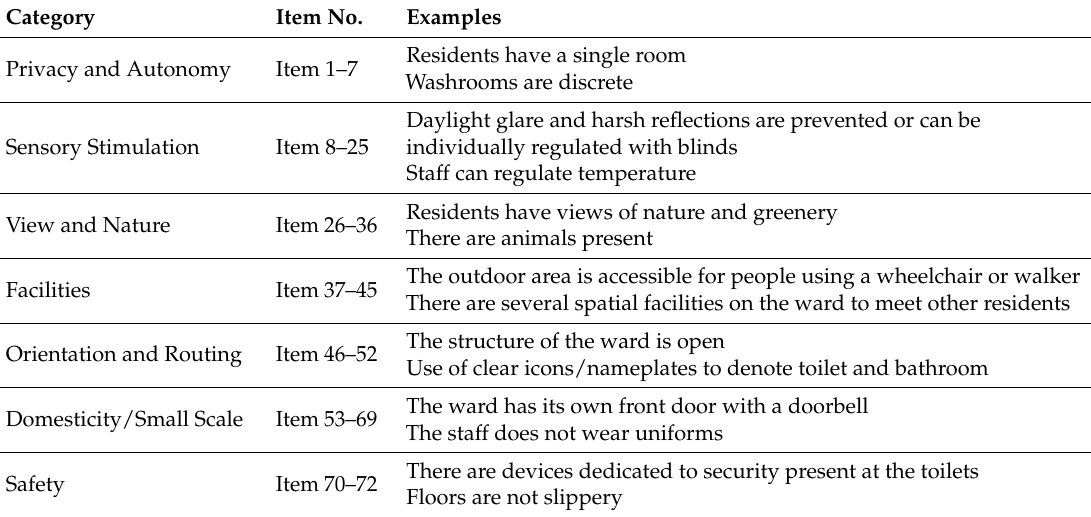
Table 2. OAZIS-Dementia categories and example